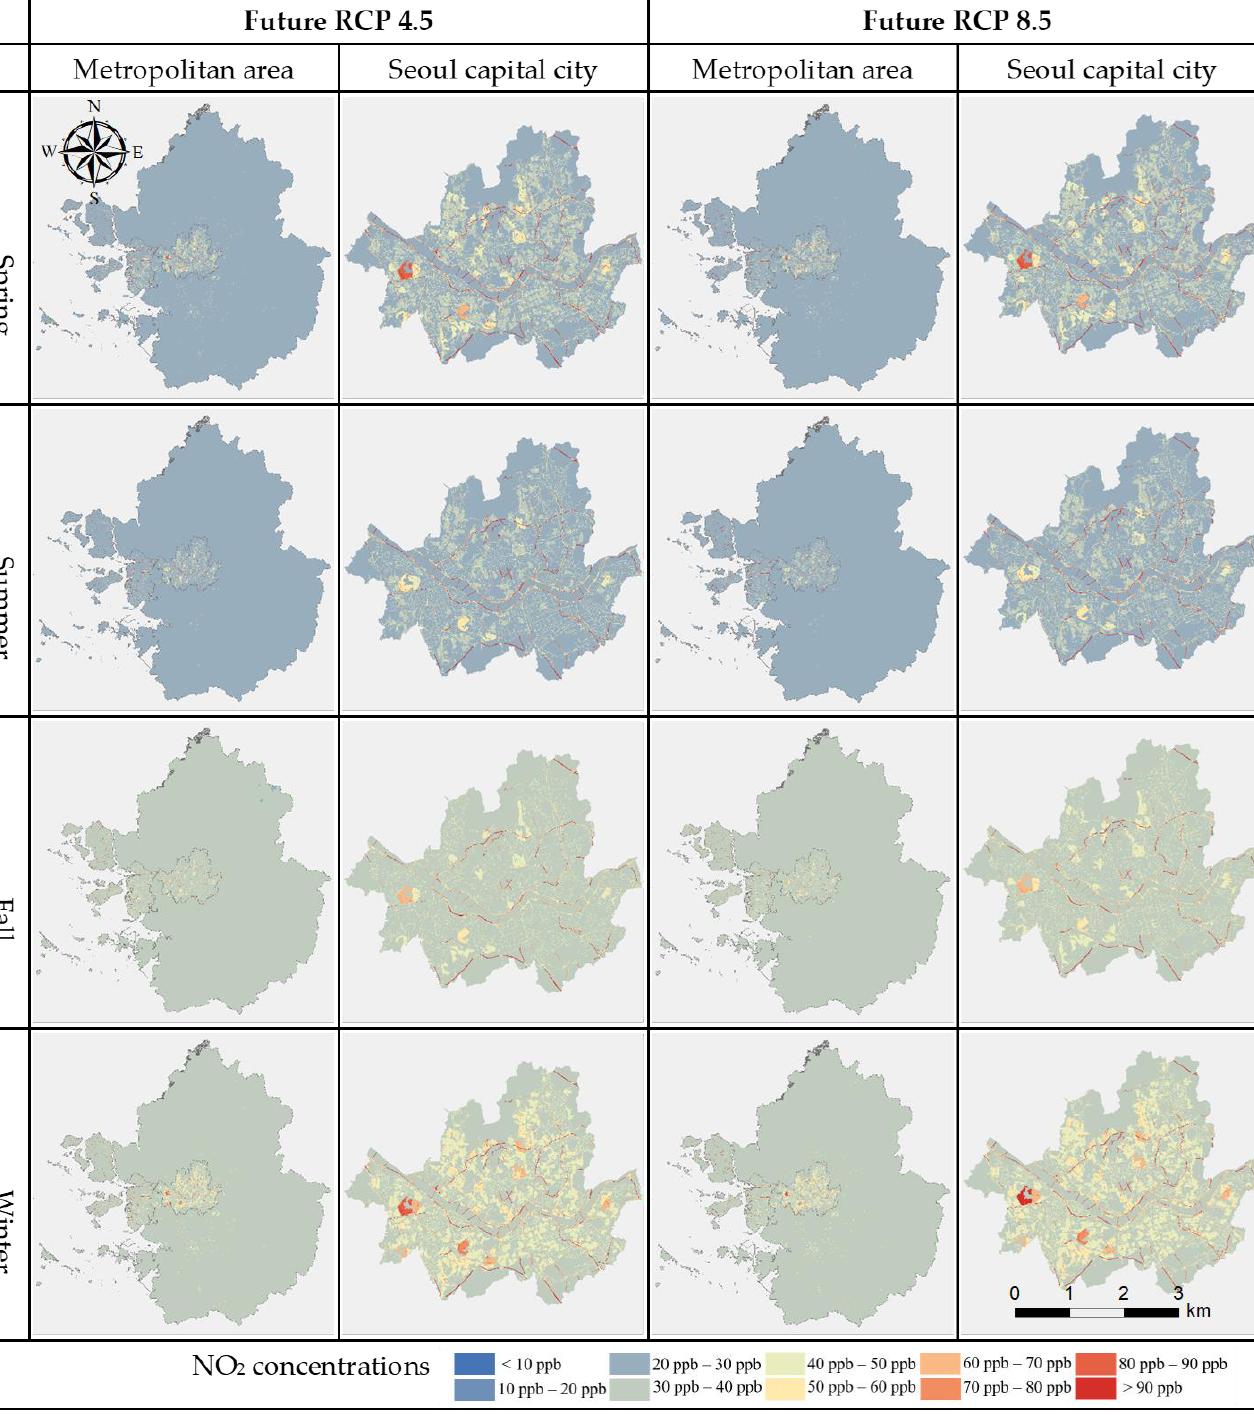
Figure 5. Future (2070) LUR seasonal models of the whole study area (Metropolitan area) and Seoul capital city under RCP scenarios 4.5 and 8.5.